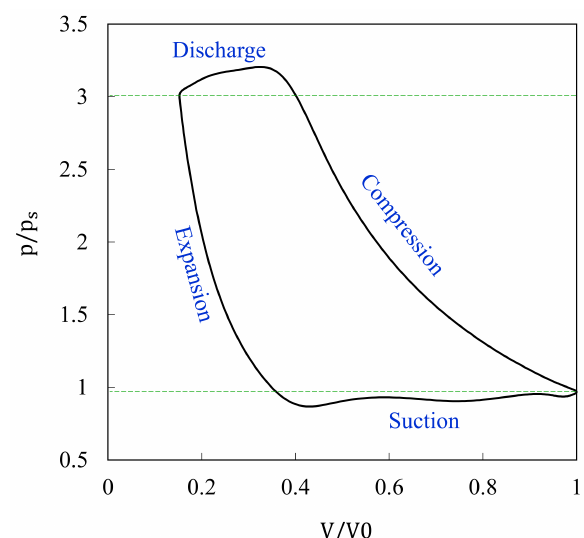
Figure 2. p − V diagram.